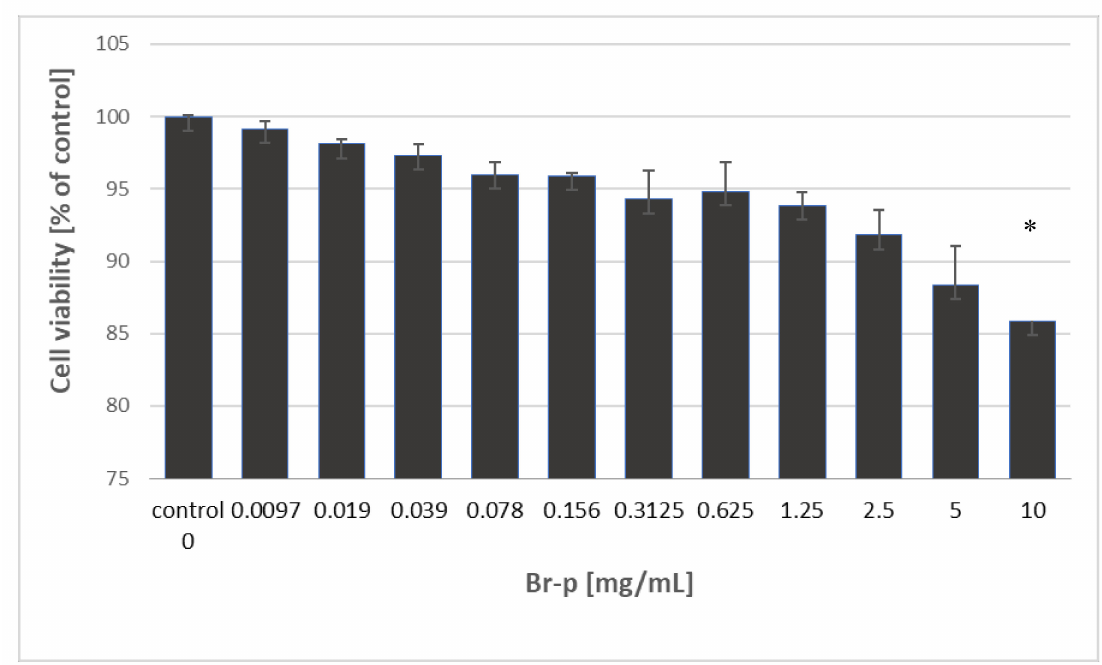
Figure 4. The graph of the human fibroblasts (BJ) viability depending on the concentration of Br-p against a control; * statistically significant results compared to the